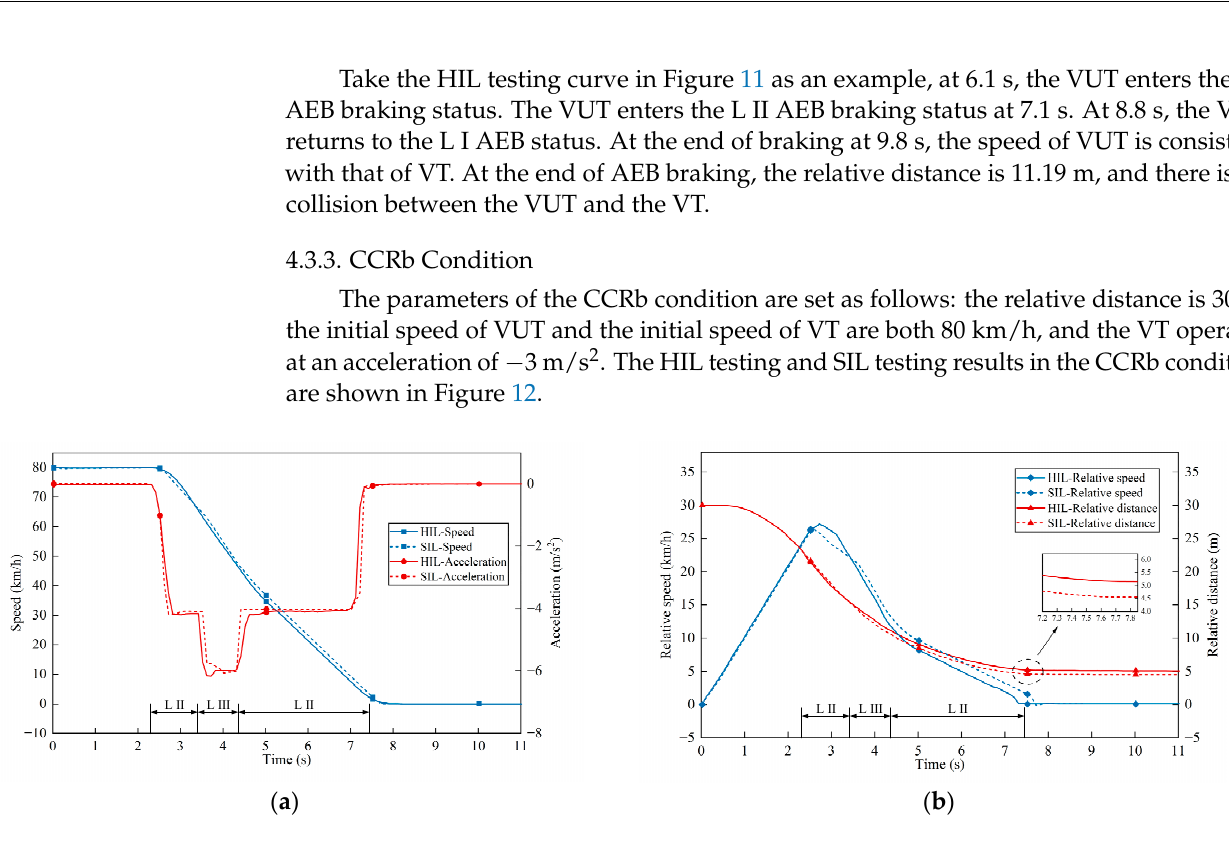
Figure 11. HIL testing and SIL testing results of CCRm condition: ( a ) speed of VUT and acceleration of VUT; ( b ) relative speed and relative distance.